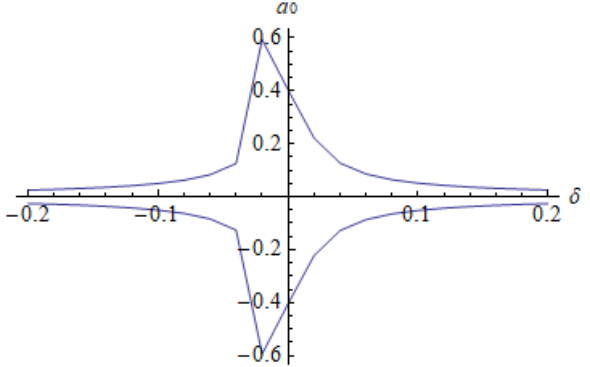
Figure 3. The variation of a 0 given by Equation (61) on the domain [-0.2,0.2].